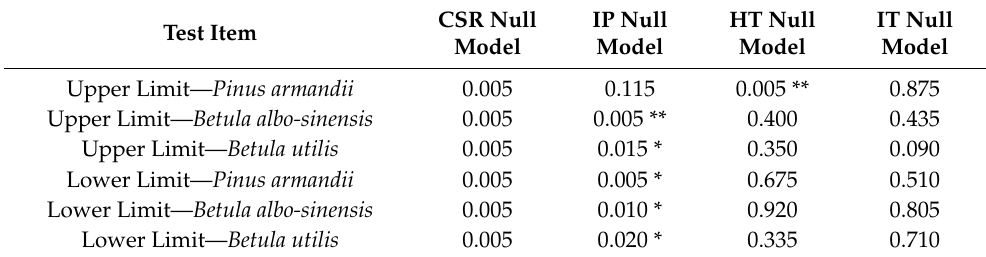
Table 3. GoF test significance for Complete spatial randomness, Inhomogeneous Poisson, Homoge- neous Thomas and Inhomogeneous Thomas null model fit effects.